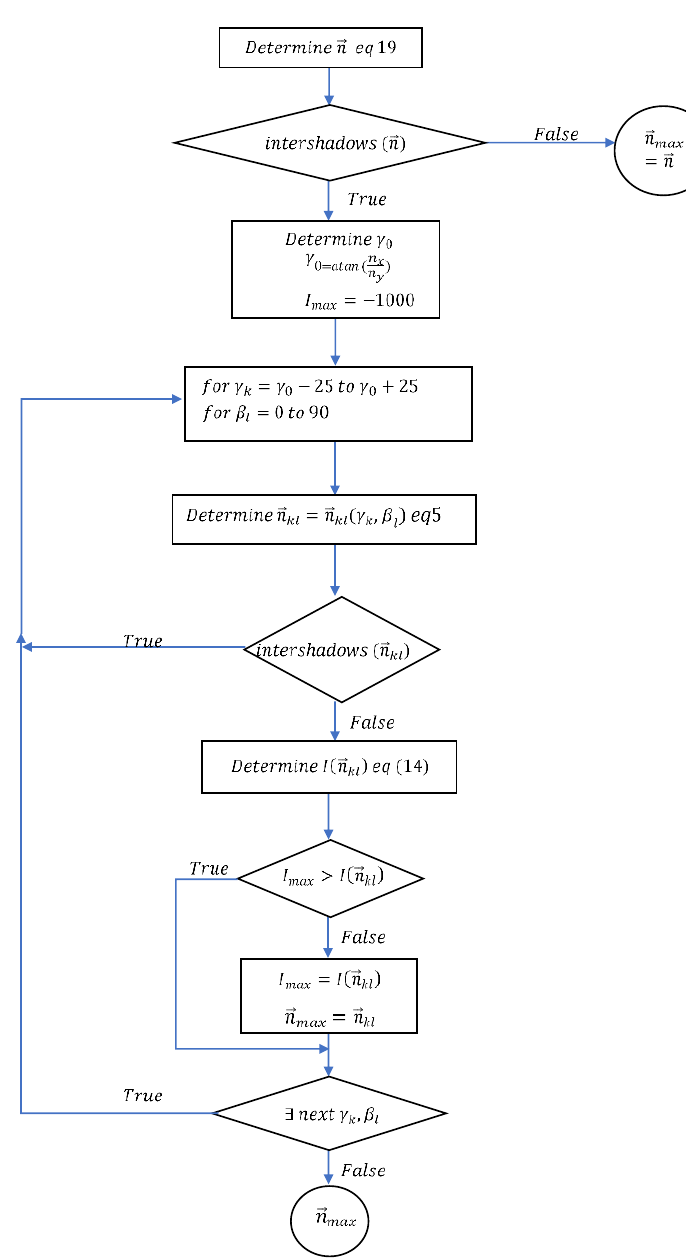
→ n of maximum irradiance uptake without any